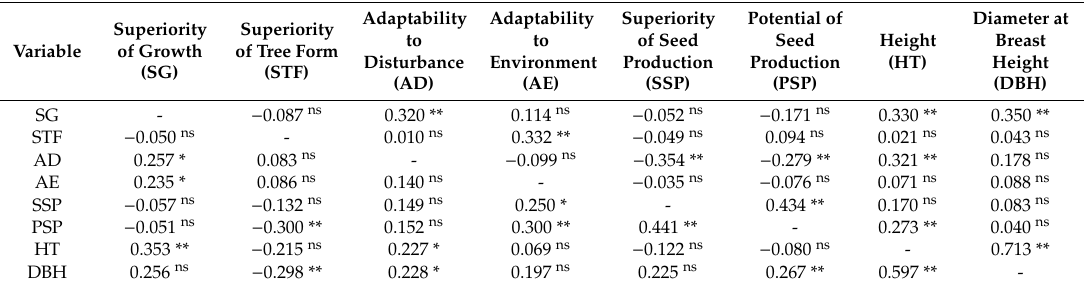
Table 5. Spearman rank correlations among variables measured from candidate trees of Quercus salicina (upper diagonal) and Q. glauca (lower